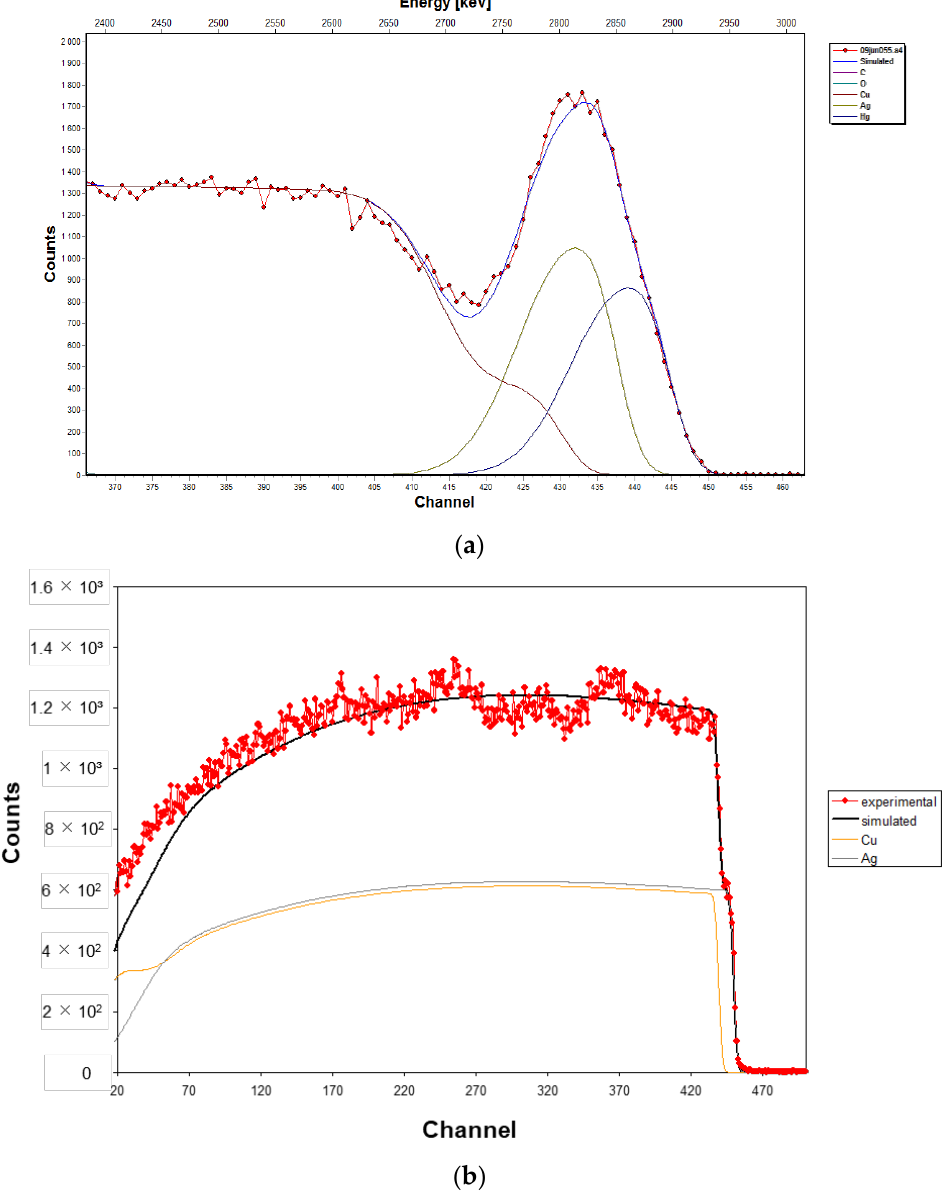
Figure 5. The 3 MeV proton Rutherford backscattering spectrometry (RBS) spectrum of a counterfeit coin ( a ) and that of an official coin ( b ). For the counterfeit coin, RBS shows a silver-mercury layer on a copper substrate, whereas for the official coin, RBS shows a homogeneous silver-copper alloy.